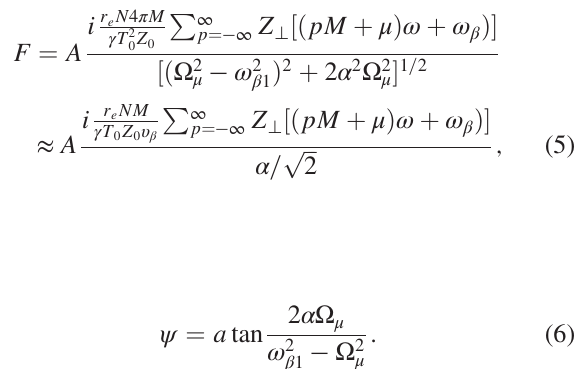
FIG. 2. Vertical tune shift produced by the vertical kicker (located at the end of the second straight section) at the SSRF storage